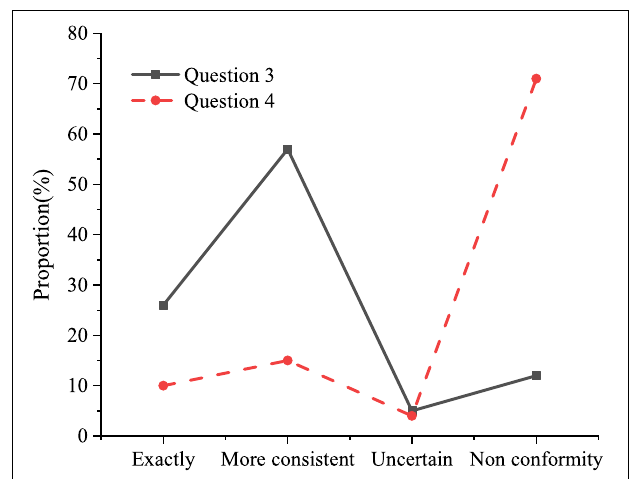
FIGURE 3 | The results of the questionnaire on educational